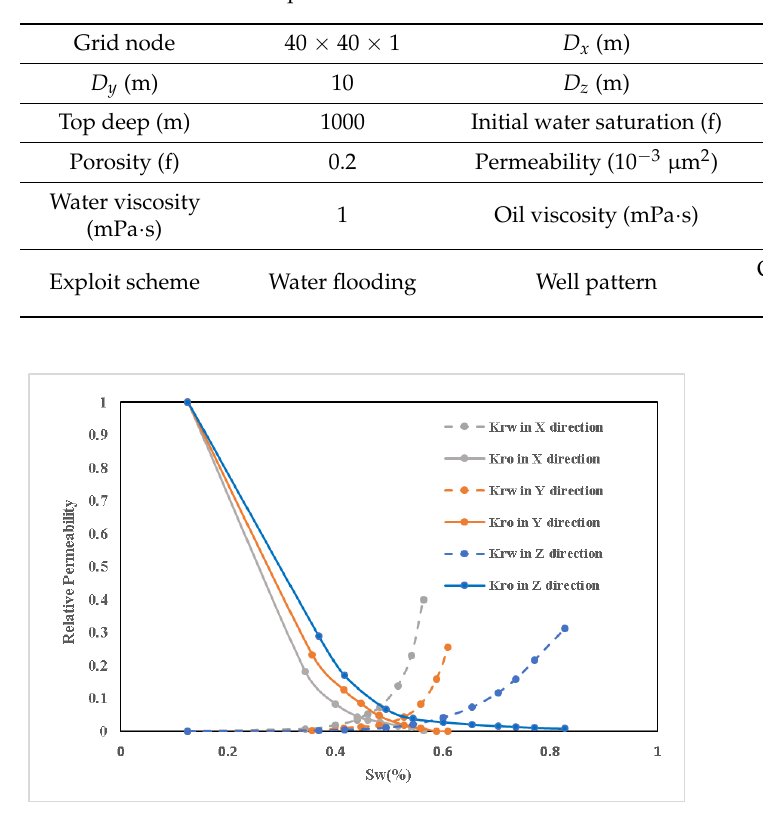
Table 1. Simulation model parameters.